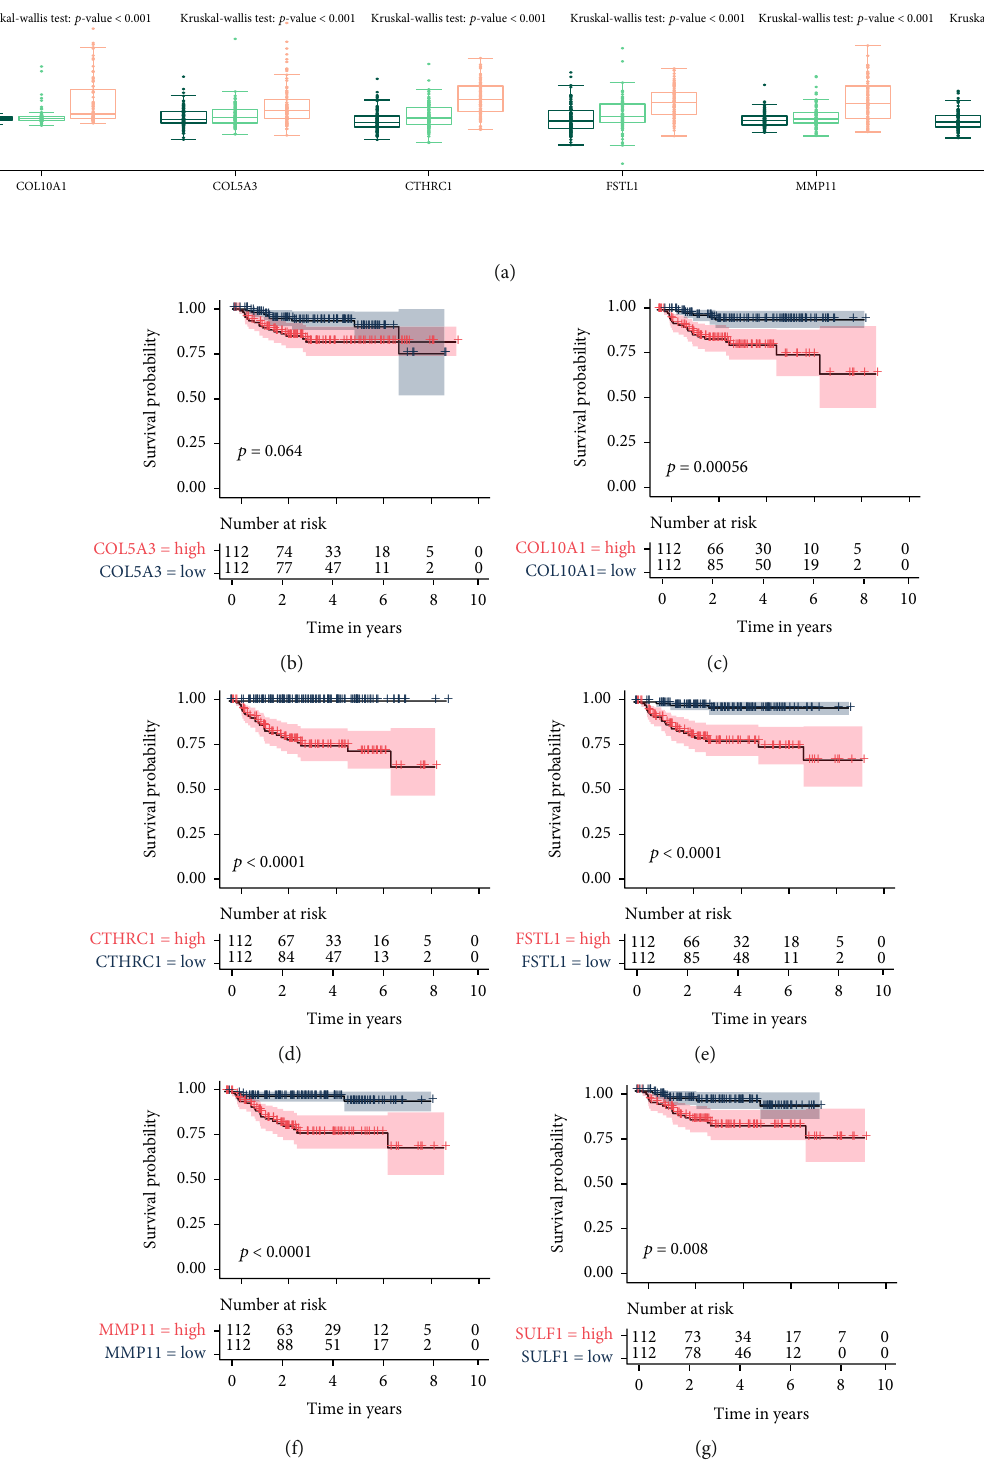
Figure 3: The association of ECM hub genes (COL10A1, COL5A3, CTHRC1, FSTL1, MMP11, and SULF1) with stage and prognosis of bladder cancer of GSE32894. (a) Gene expression of genes in bladder cancer patients according to clinical stage. Analysis of the relationship between (b) COL5A3, (c) COL10A1, (d) CTHRC1, (e) FSTL1, (f) MMP11, (g) SULF1, and bladder cancer survival prognosis based on the